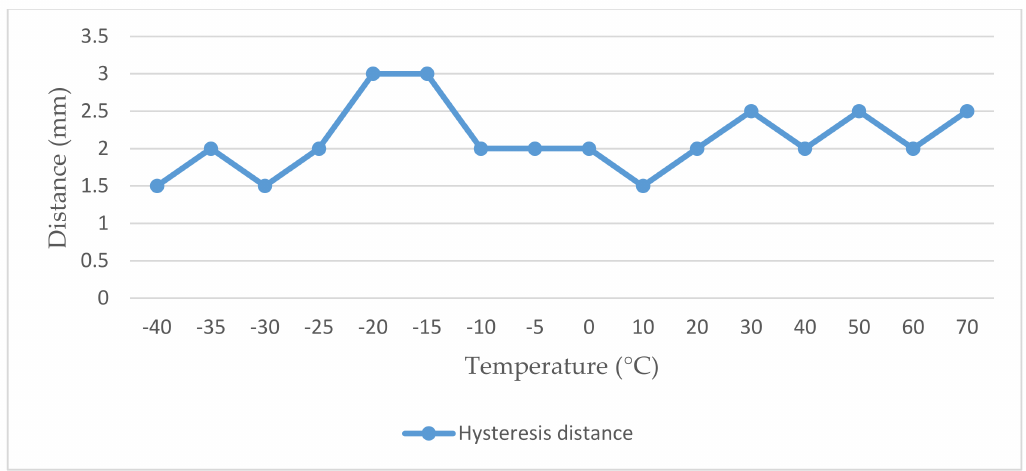
Figure 6. Graphical representation of the values of the hysteresis phenomenon of the magnetic contact MAS333.